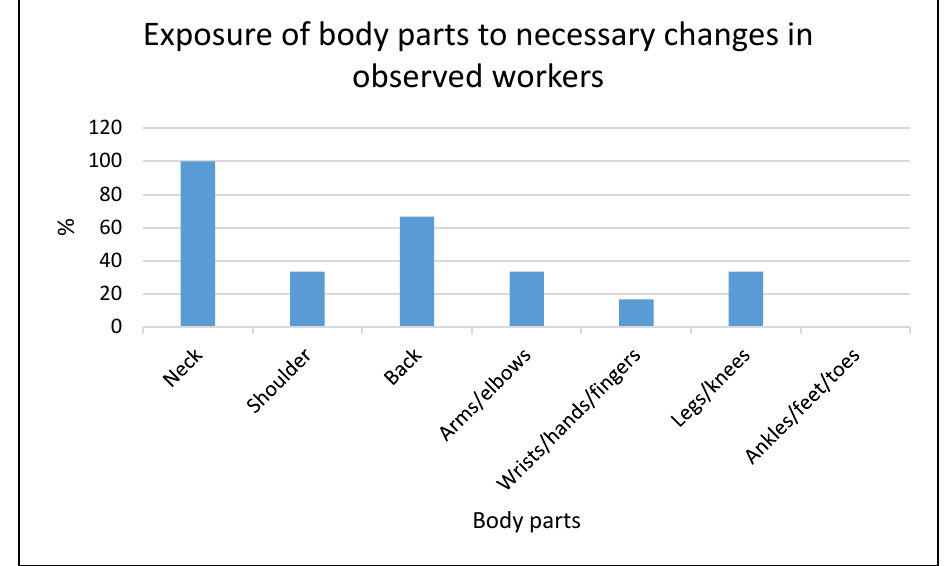
Figure 4. Exposure of body parts to necessary changes in observed workers. Source: (Authors).